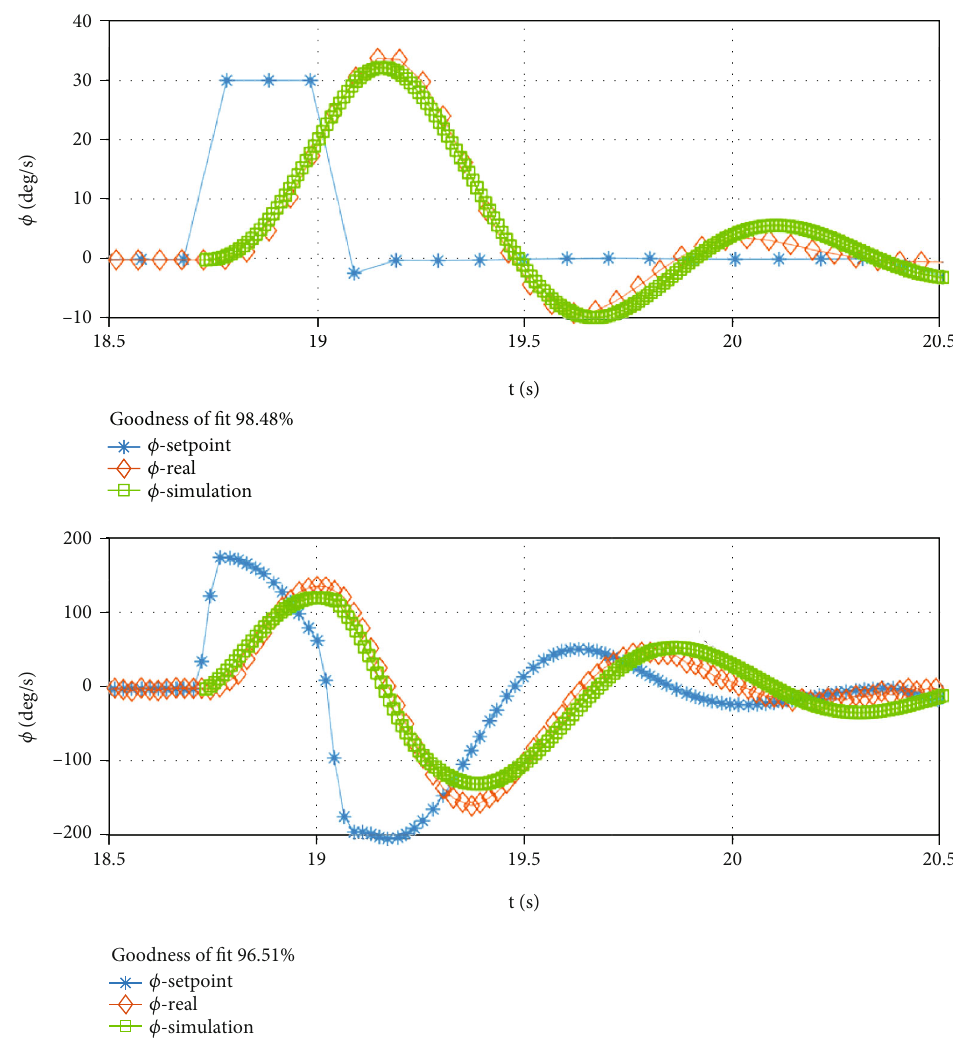
Figure 10: Roll mode dynamic response comparison under a 0.3-s impulse